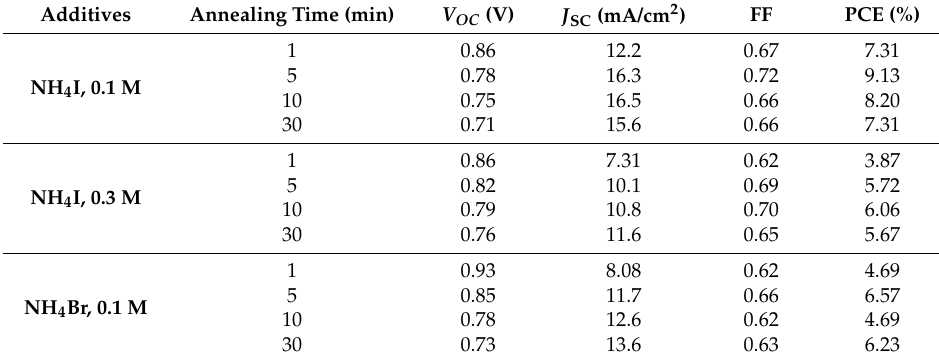
Figure 5. ( a ) Current density ‐ voltage curves of CH 3 NH 3 PbI 3 ‐ x Cl x PSCs, without any additives. The samples were annealed at 100 °C for 1, 5, 10, and 30 min, respectively. The optimal annealing time was 10 min with PCE 5.40%. Current density ‐ voltage curves of CH 3 NH 3 PbI 3 ‐ x Cl x PSCs with additives of ( b ) 0.1 M NH 4 I, ( c ) 0.3 M NH 4 I, ( d ) 0.1 M NH 4 Br, ( e ) 0.3 M NH 4 Br, ( f ) 0.1 M NH 4 Cl, and ( g ) 0.3 M NH 4 Cl, respectively. The maximum average PCE values of the CH 3 NH 3 PbI 3 ‐ x Cl x PSCs with NH 4 I, NH 4 Br, and NH 4 Cl additives are 9.13, 6.57, and 8.13%, respectively. Table 1. Photovoltaic performance of CH 3 NH 3 PbI 3-x Cl x PSCs with films treated with NH 4 I, NH 4 Br, and NH 4 Cl additives. The average values are from 20 cells for each type of device, with AM 1.5 G solar